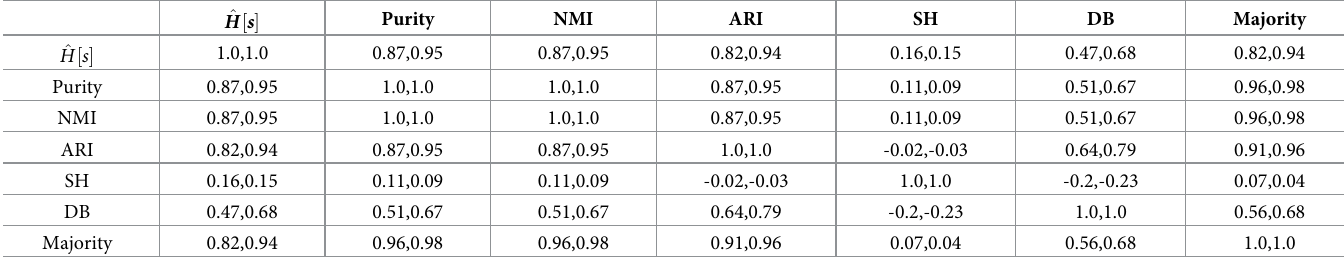
Table 10. Kendall’s τ and Spearman’s correlation result for